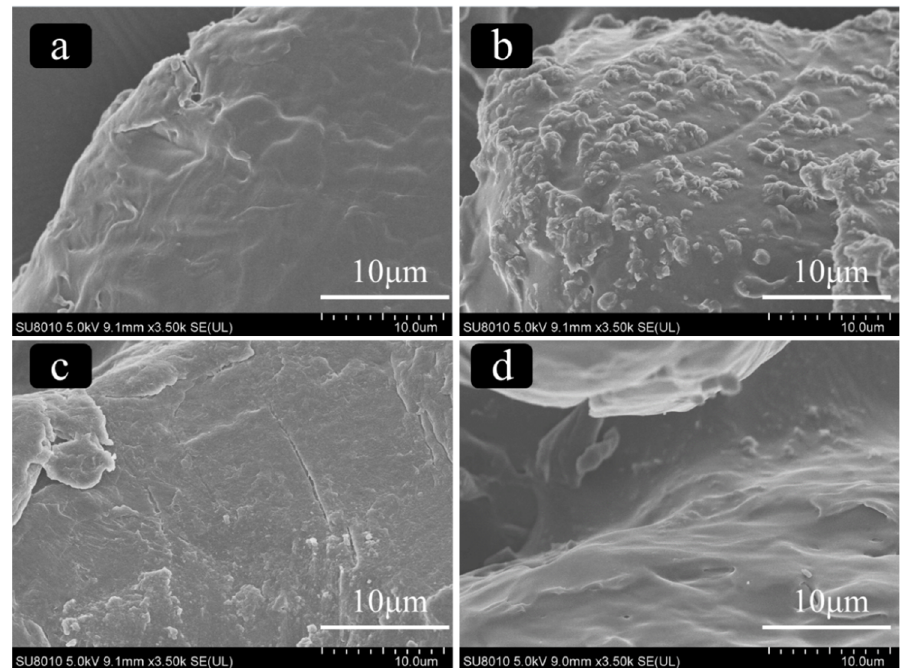
Figure 1. SEM images of the surface microstructure of PS and PBAT before and after UV aging (( a ) pristine PBAT, ( b ) aged PBAT, ( c ) pristine PS, and ( d ) aged